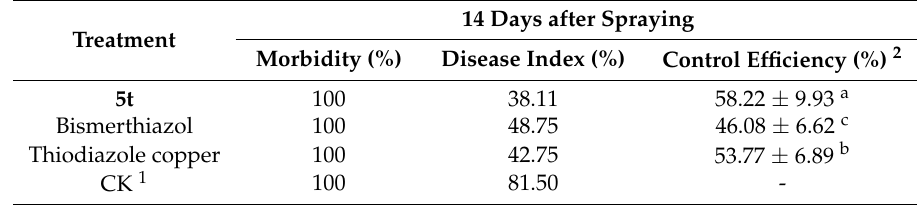
Table 5. Protective activity of compound 5t against rice bacterial leaf streak. Treatment